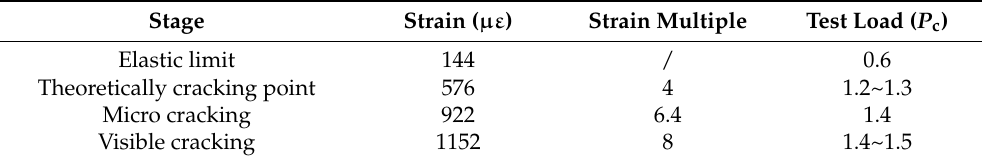
Table 9. Corresponding loads of mortar in different states at the springing